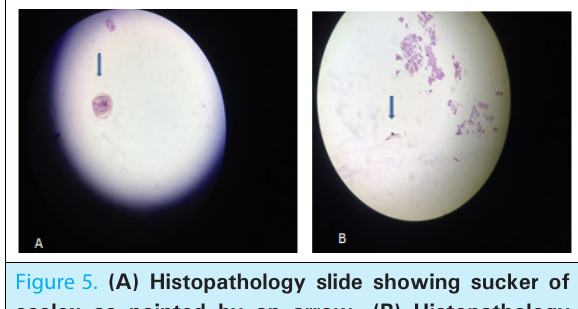
Figure 5. (A) Histopathology slide showing sucker of scolex as pointed by an arrow. (B) Histopathology slide showing hook of the